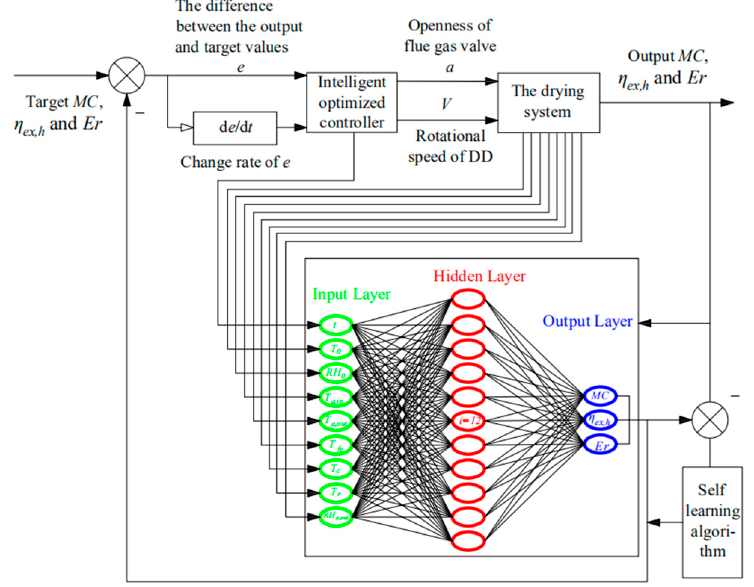
Figure 10. The proposed control model structure of industrial corn drying system.